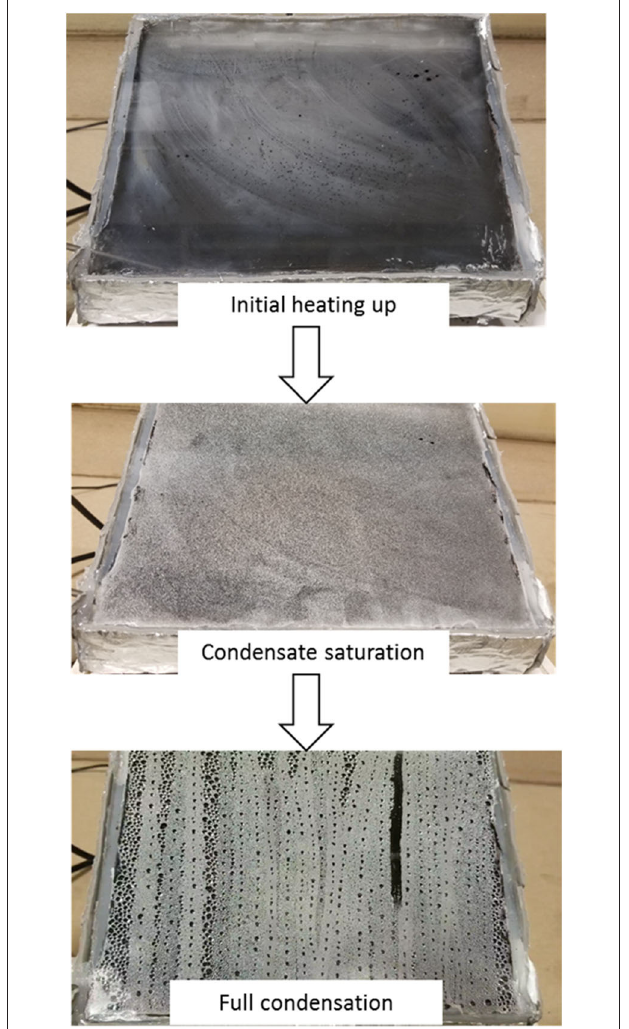
FIGURE 1 | Visual observation of the advanced solar thermal still during desalination